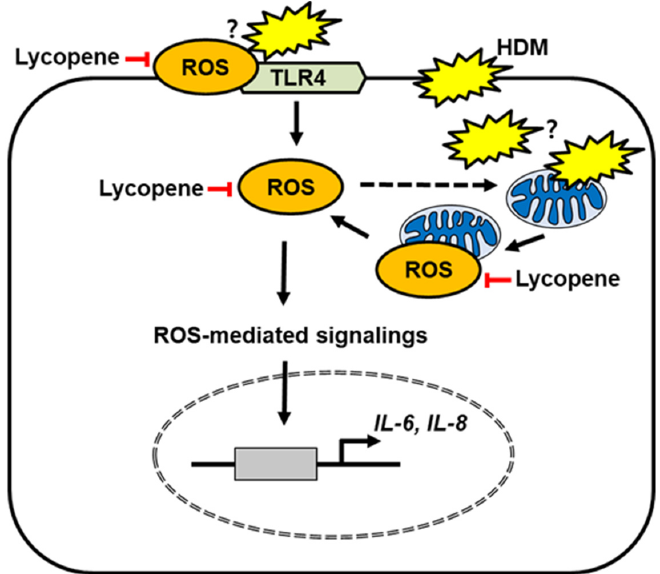
Figure 6. The proposed mechanism by which lycopene inhibits Toll like receptor 4 (TLR4)-mediated expression of inflammatory cytokines in house dust mites (HDM)-stimulated respiratory epithelial cells. HDM may increase the production of reactive oxygen species (ROS) and subsequent TLR4 activation, leading to increasing intracellular ROS levels in the cells. High amounts of ROS may cause mitochondrial dysfunction (dotted line) and increase mitochondrial ROS. In addition, HDM may directly attack mitochondria and increase mitochondrial ROS levels. ROS mediate inflammatory signalings, which induces expression of IL-6 and IL-8. Lycopene reduces ROS levels and inhibits TLR4 activation for cytokine expression. Lycopene scavenges mitochondrial ROS and subsequently suppresses expression of IL-6 and IL-8 in HDM-stimulated respiratory epithelial